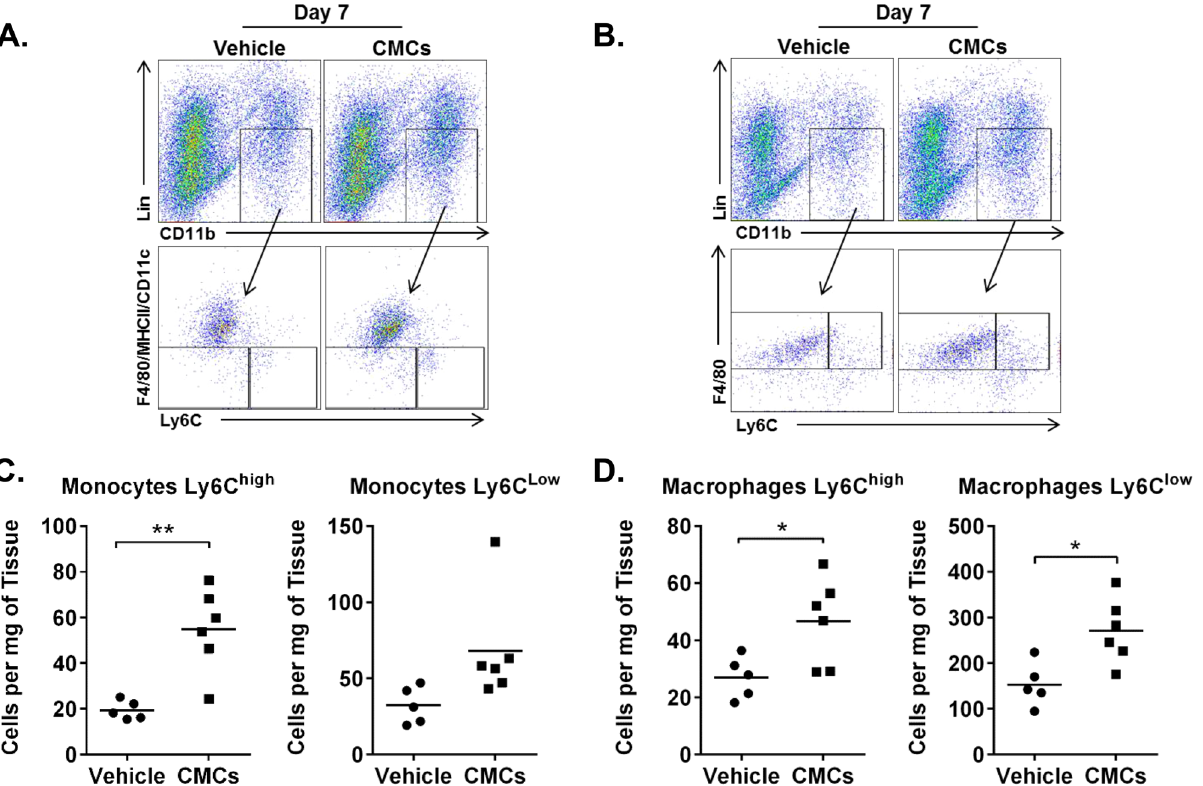
( unpaired t test